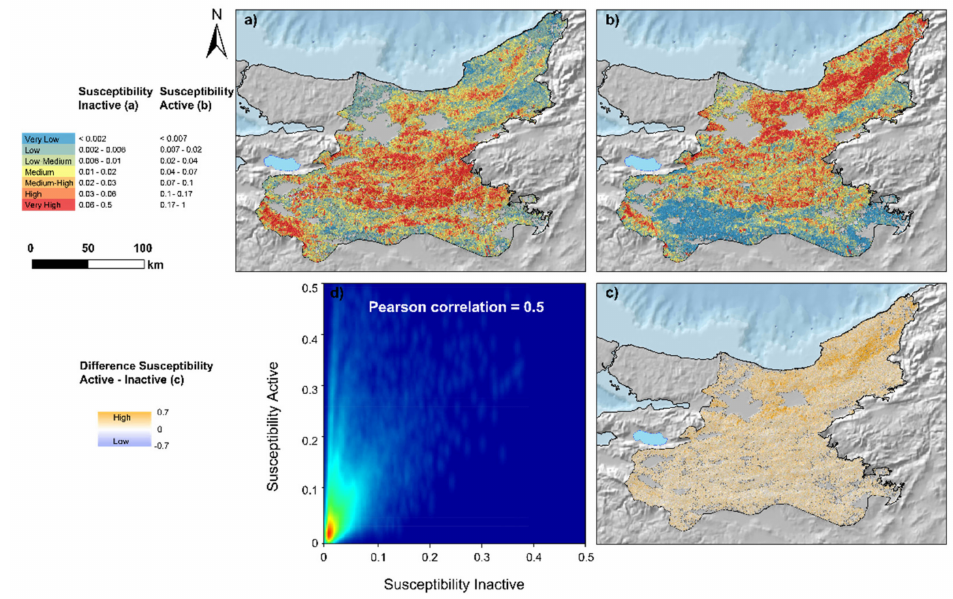
Figure 6. Susceptibility maps for inactive ( a ) and active ( b ) landslides. The maps are obtained by merging ten cross-validated subsets and thus entirely come from predicted estimates. The resulting probability values have been binned into seven susceptibility classes using a quantile criterion. The difference in susceptibility between ( a ) and ( b ) is shown in ( c ), while the graph in ( d ) displays their Pearson